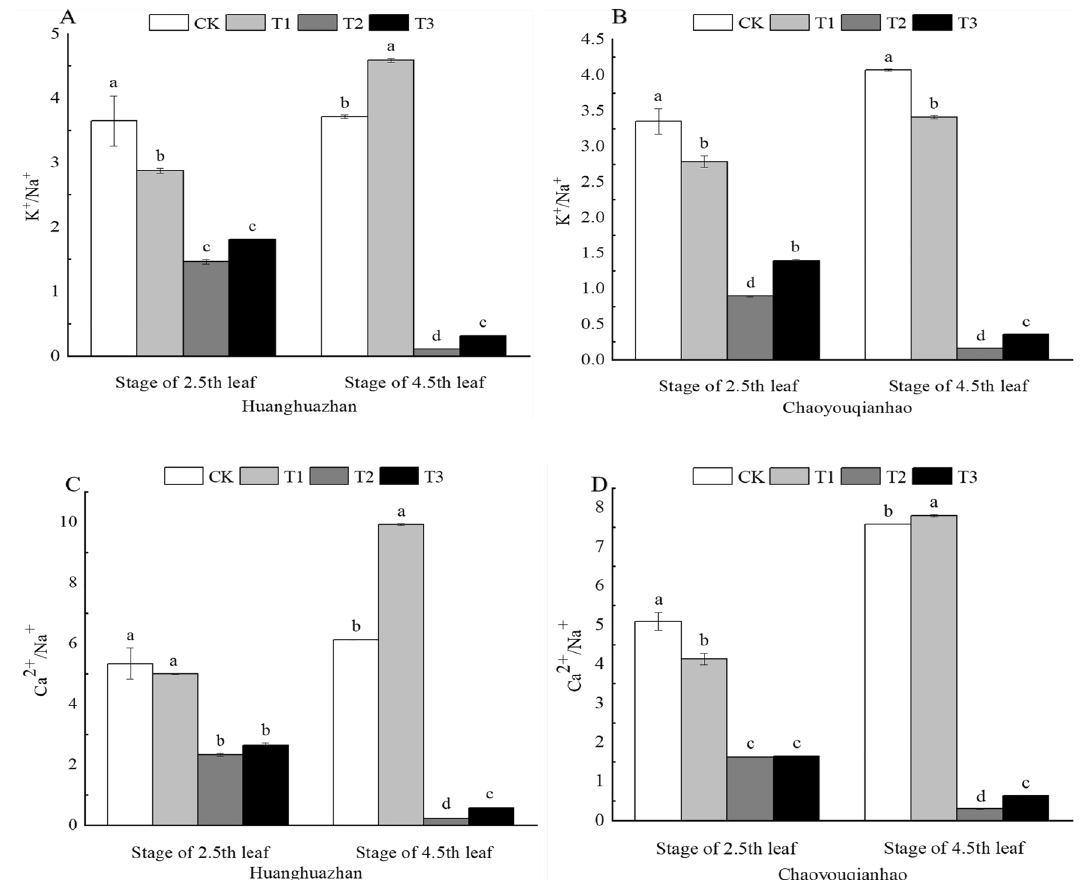
Figure 9. Effects of soaking with BR on Ion homeostasis of rice seedlings under salt stress. Different lowercase letters indicate significant differences at the P < 0.05 level. CK: soaking with distilled water + watering 0 g L −1 NaCl. T1: soaking with BR + watering 0 g L −1 NaCl. T2: soaking with distilled water + watering 3 g L −1 NaCl. T3: soaking with BR + watering 3 g L −1